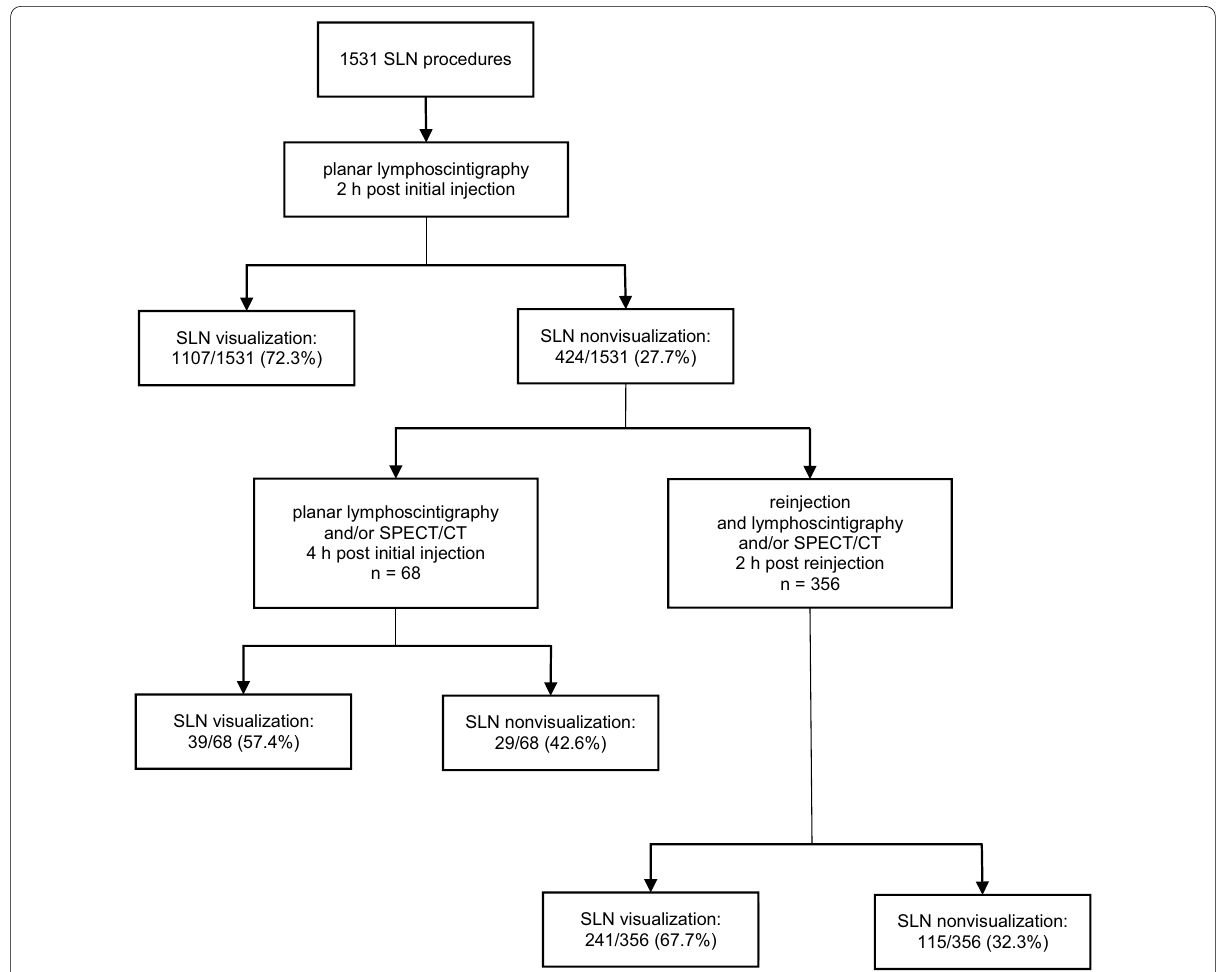
Fig. 1 Flowchart of procedures with and without preoperative SLN